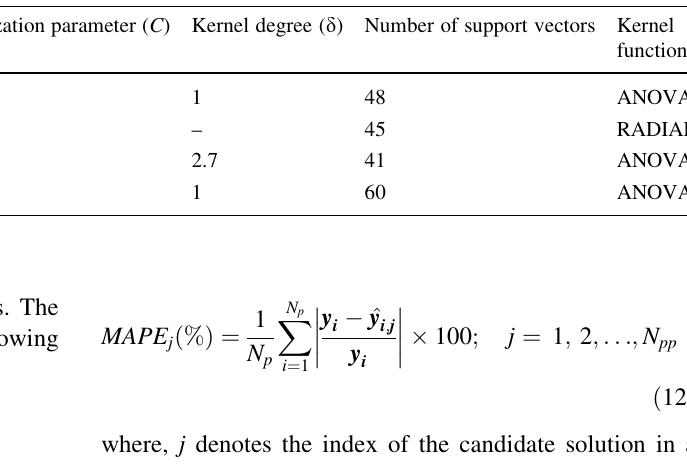
Table 5 Details of the SVR-based models predicting IDT , ST, HT, and